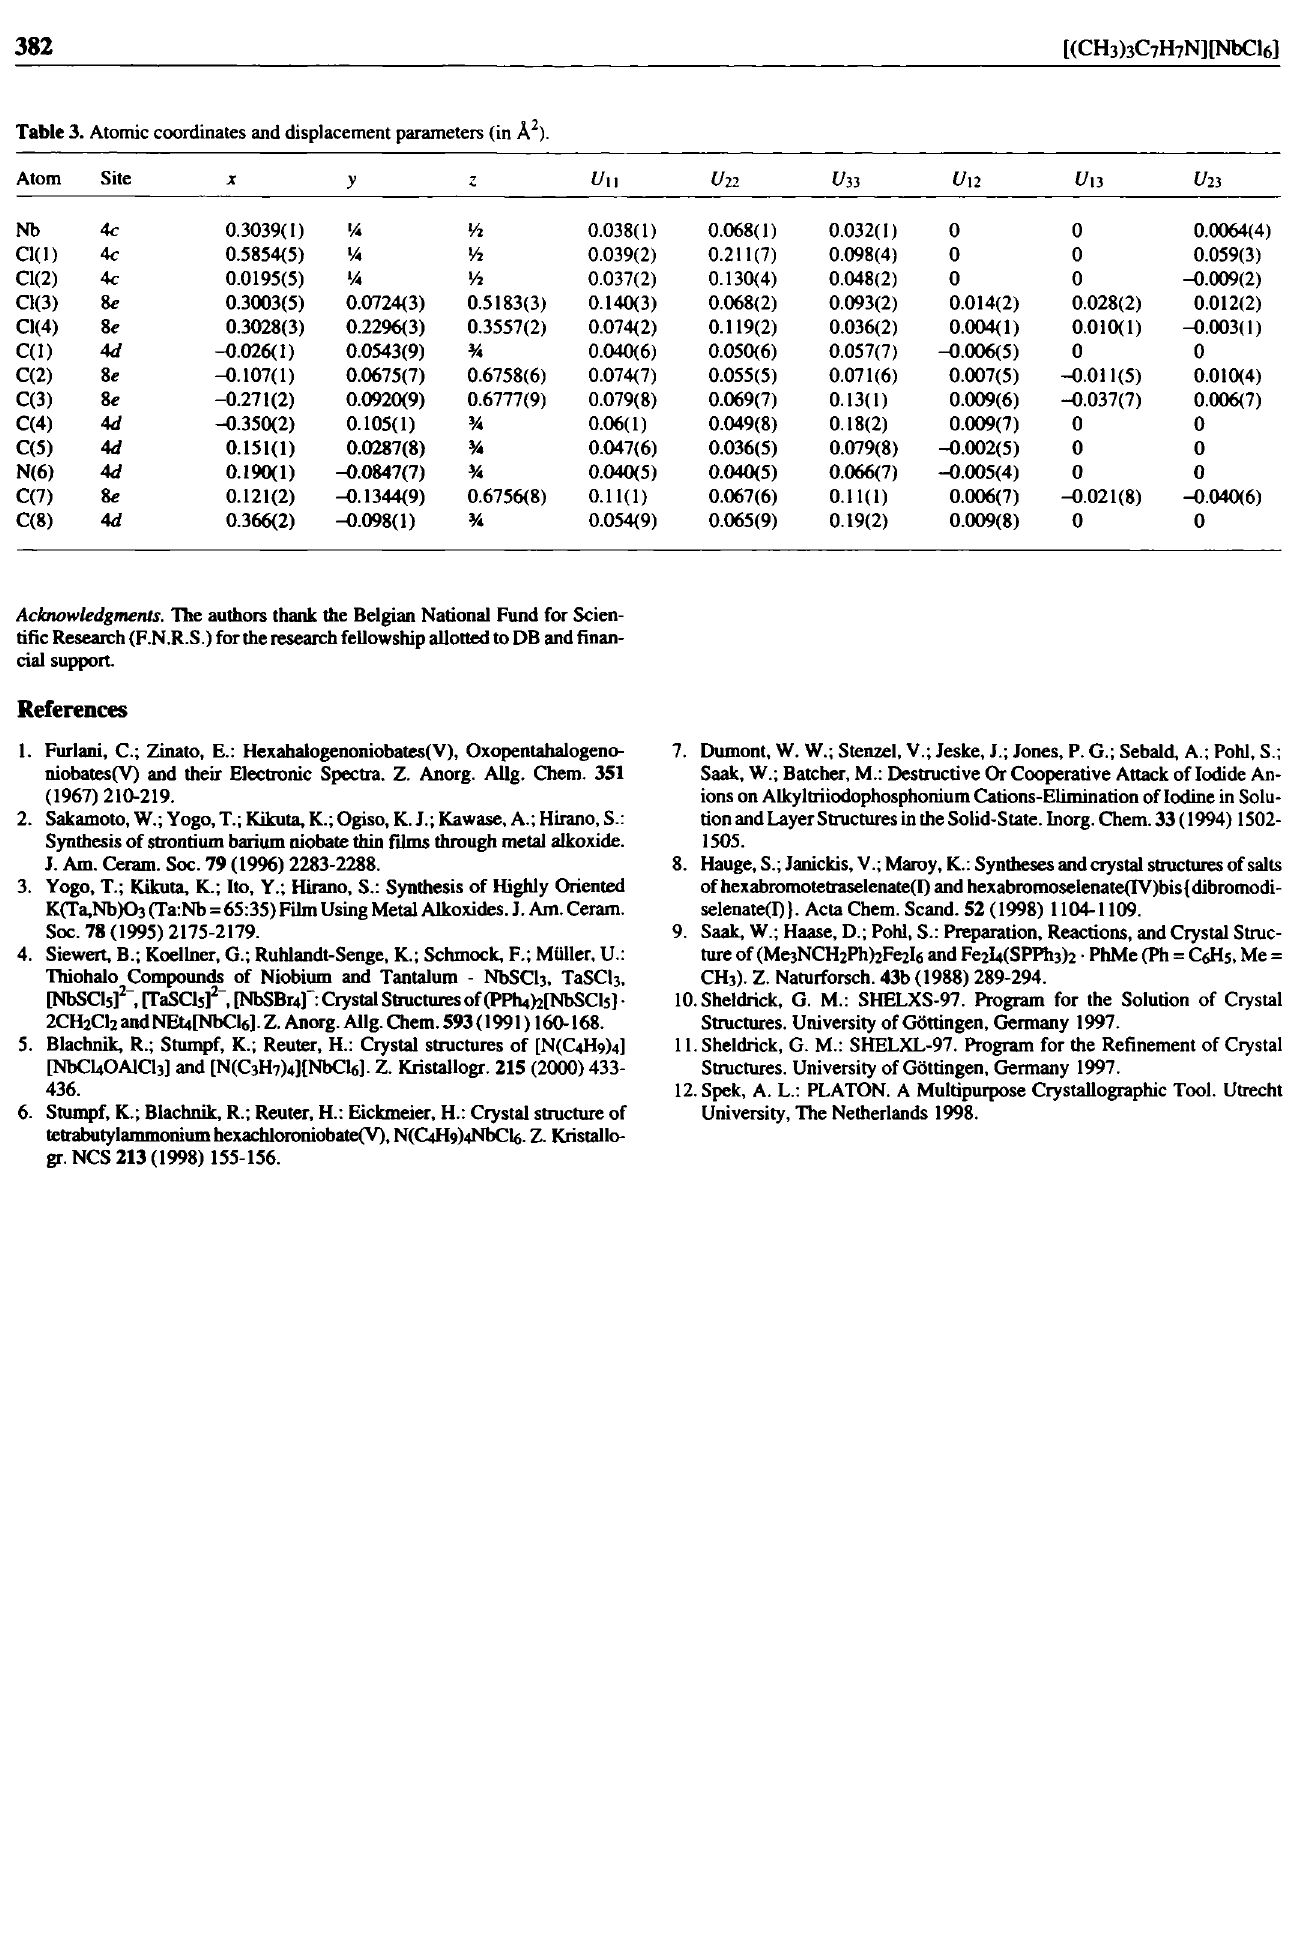
Table 3. Atomic coordinates and displacement parameters (in Â 2